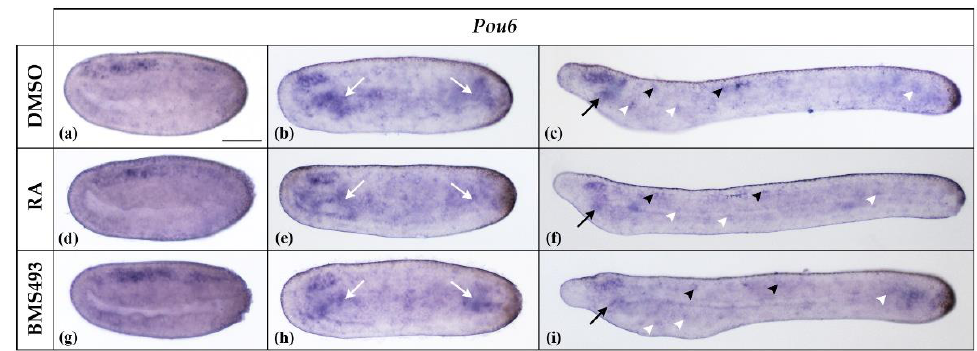
Figure 4. Expression of Pou6 in N2-, N4-, and T1-stage Branchiostoma lanceolatum embryos. ( a – c ) Control embryos (DMSO-treated). ( d – f ) Retinoic acid (RA) signaling activation with all- trans retin- oic acid (RA). ( g – i ) RA signaling inhibition with the inverse agonist BMS493. In N2 neurulae ( a , d , g ), Pou6 is weakly expressed in the neural plate, with the strongest signal being located in its anterior half. At stage N4 ( b , c , h ), Pou6 expression is detectable in the anterior nerve cord (in the region of the prospective cerebral vesicle) and in the endoderm (white arrows). In T1 embryos ( c , f , i ), Pou6 is expressed in the cerebral vesicle, the anterior and posterior endoderm, including the preoral organ (black arrow), and in scattered cells of the nerve cord (black arrowheads) and the ectoderm (white arrowheads). Whole mount embryos are shown in lateral view; the anterior is to the left. The scale bar in ( a ) is 50 μm and is valid for all panels.